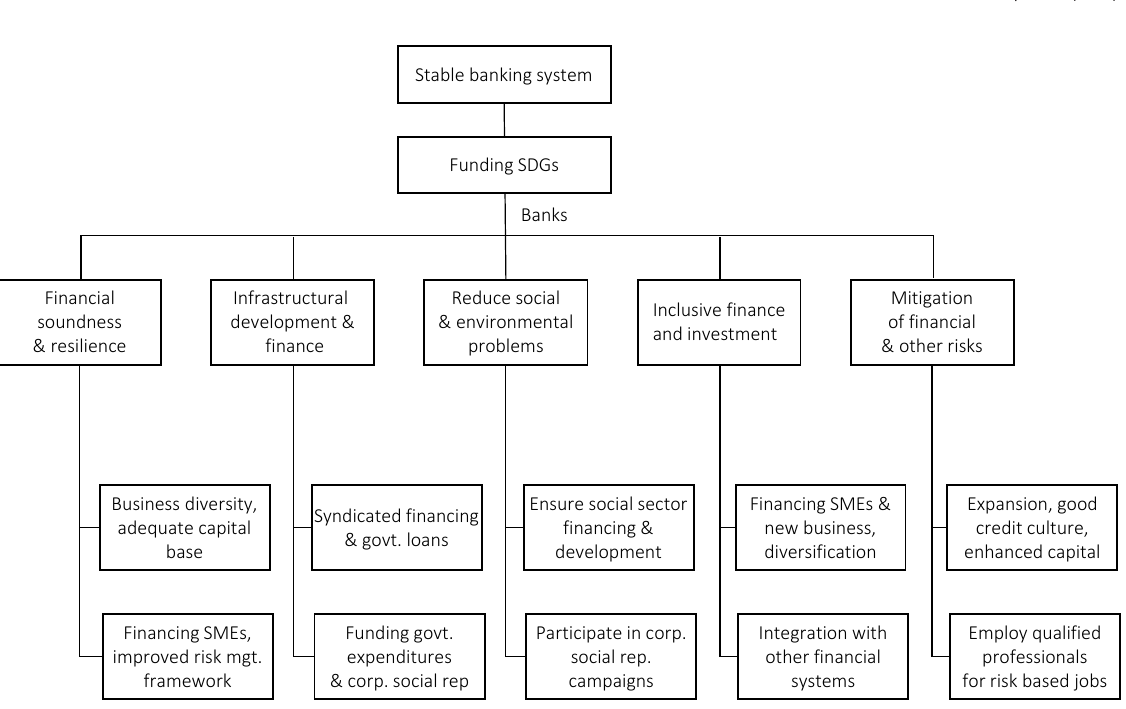
Figure 1. A stable banking system and SDG funding